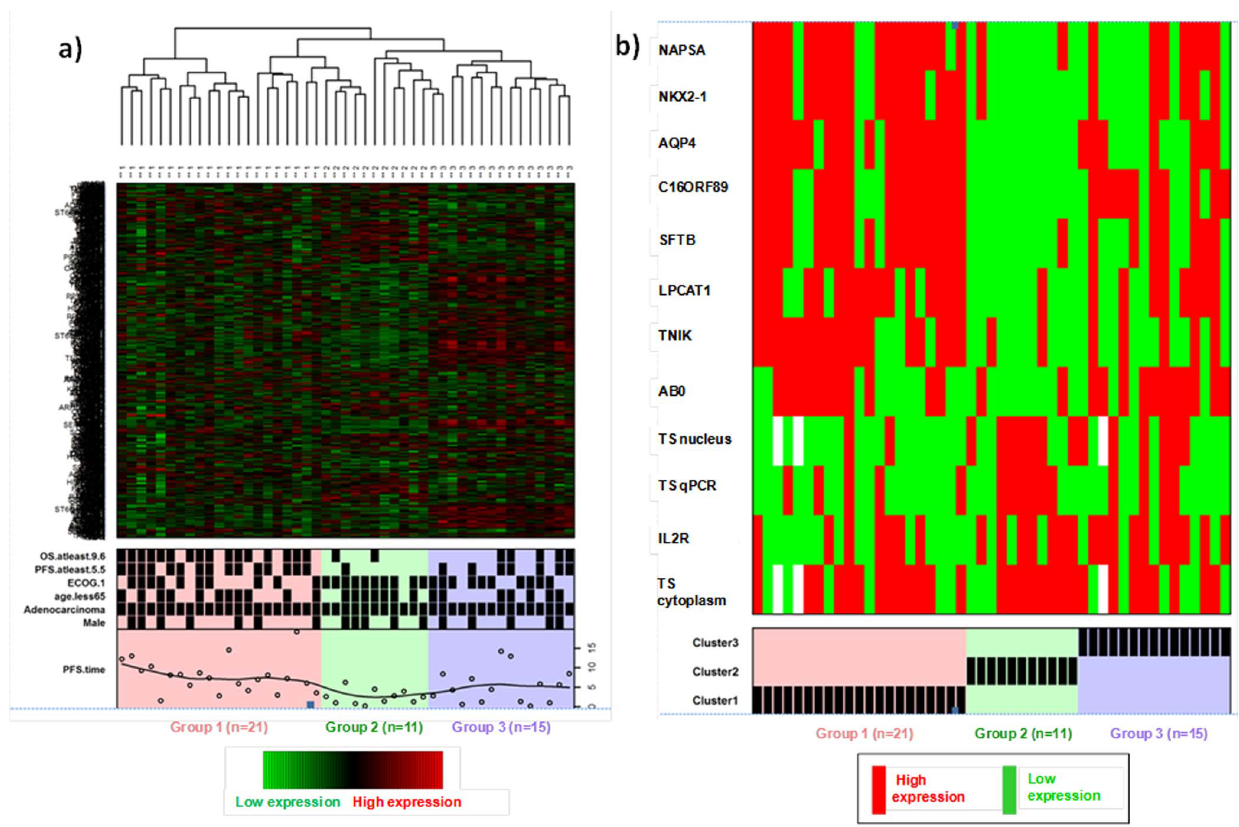
Figure 1. Cluster analysis: Heatmap profiles of adenocarcinoma patients with microarray mRNA data (n=47). 1a: Columns of the heatmap represent the samples with annotated cluster membership. Rows of the heatmap represent the 870 genes on the Lung Cancer-DSA microarray in common with the set of genes used by Wilkerson et al. [2012]. Additional binary profiles are plotted for the following covariates: male, adenocarcinoma yes, ECOG performance status=1, PFS $ 5.5 months (median), OS $ 9.6 months (median), PFS time is plotted as an additional profile with added loess-smoothed curve. 1b: Binary profiles plotted for TS nucleus IHC H-score high ( $ 70), TS cytoplasm IHC H-score high ( $ 100), TS qPCR high ( $ -1.3), and high expression ( $ median cutpoint) of each of the 9 genes significantly associated with both PFS and OS in the overall sample. Abbreviations: ECOG, Eastern Cooperative Oncology Group; n, number of patients; nsNSCLC, nonsquamous non-small cell lung cancer; OS, overall survival; PFS, progression-free survival; qPCR, real-time quantitative polymerase chain reaction; TS, thymidylate synthase.